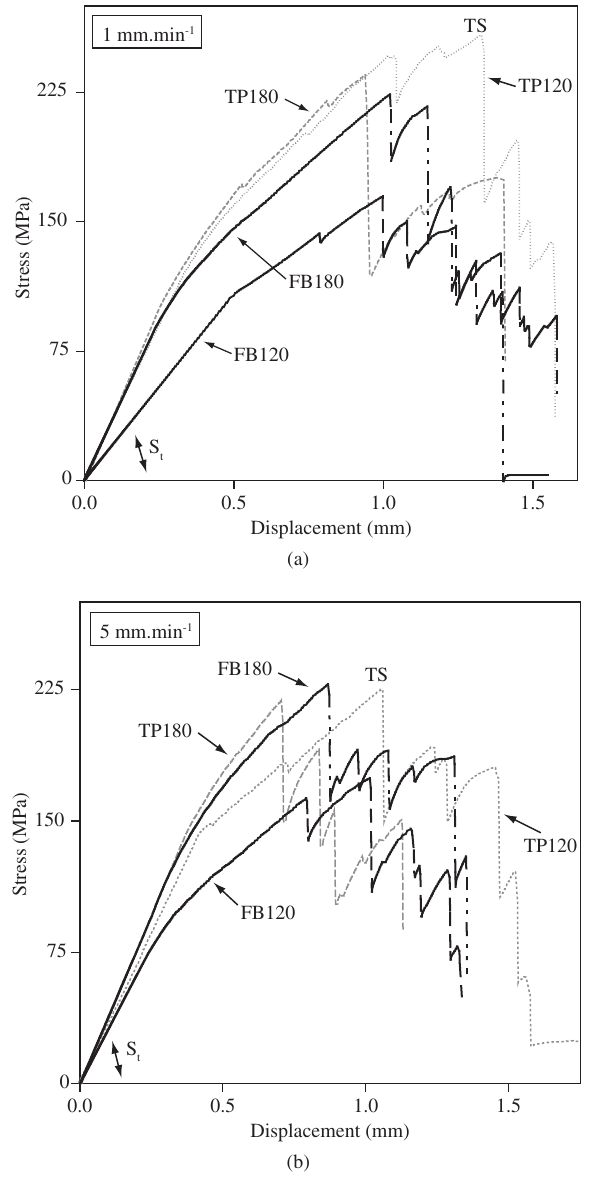
Figure 1. Stress-displacement curves for two tensile loading rates: a) 1mm/min; and b) 5mm/min.